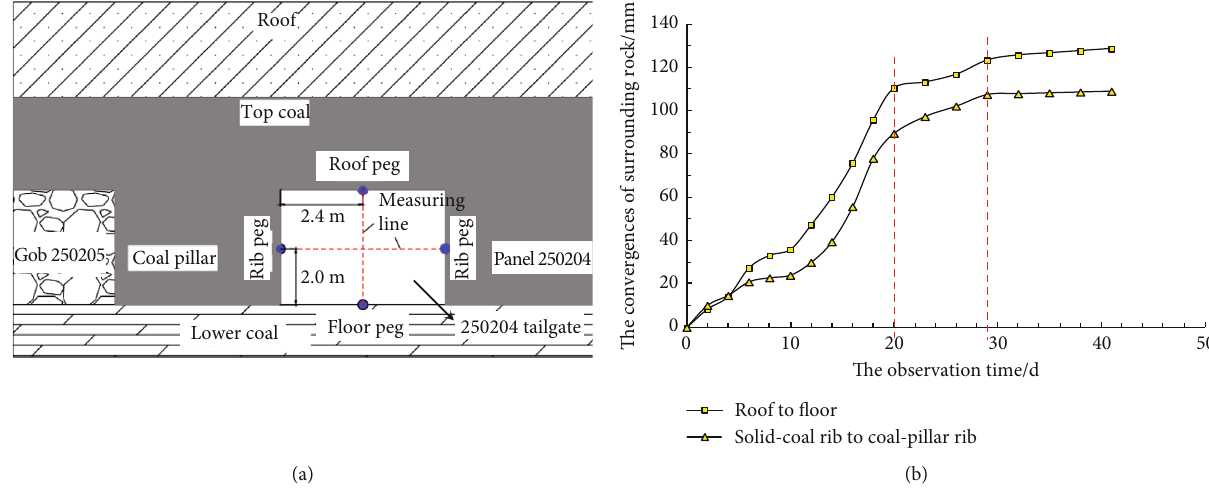
Figure 19: The “ cross-shaped ” observation method in the pressure relief roadway part. (a) Schematic diagram of “ cross-shaped ” observation method. (b) Mean convergences monitoring